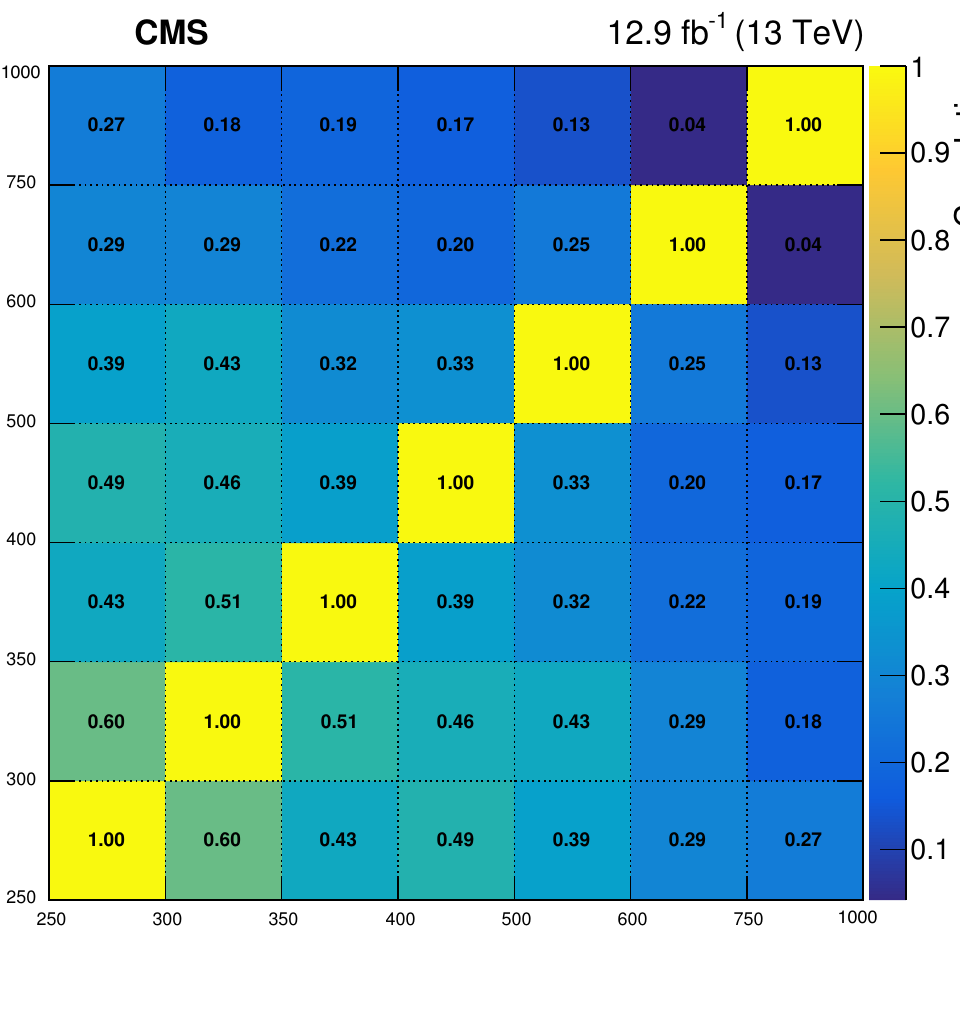
Figure 15 . Correlations between the uncertainties in the estimated background yields in all the E miss bins of the mono-V signal region. The boundaries of the E miss T shown at the bottom and on the